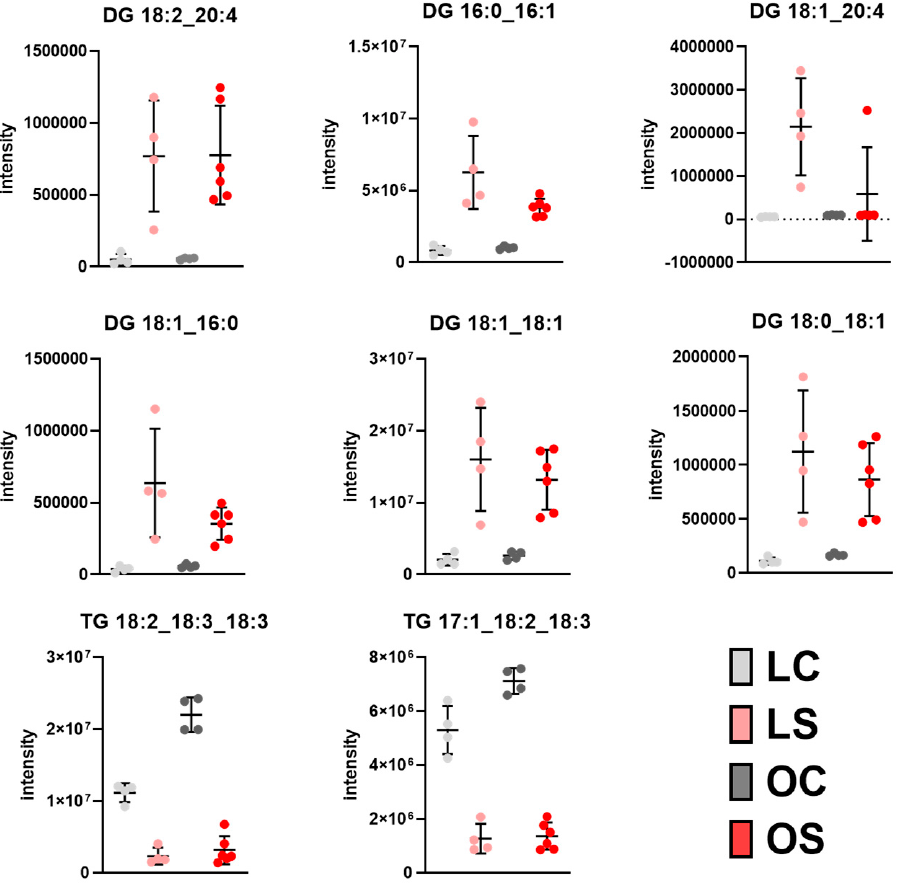
Figure 5. Intensity boxplot of lipids identified by the lipidomics approach in epididymal adipose tissue with differences in diet ( p < 0.05). LC, lean control; LS, lean supplemented with sofrito; OC, obese control; OS, obese supplemented with sofrito .